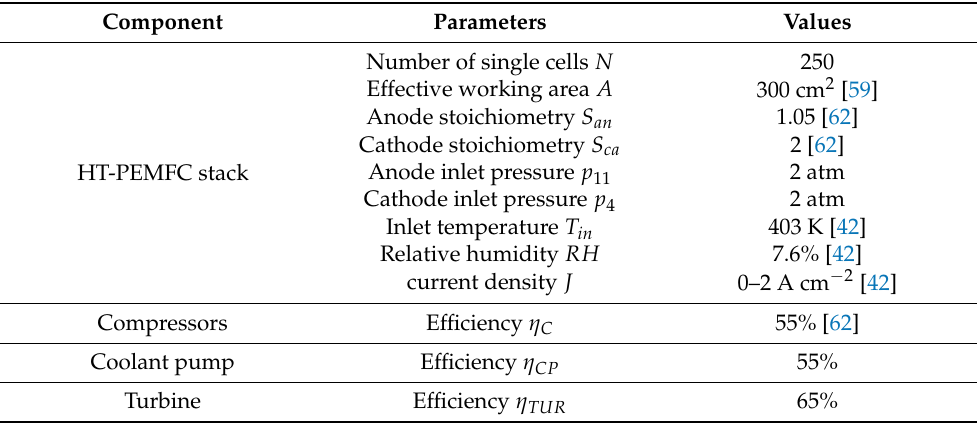
Table 1. Operating and design parameters of a vehicular HT-PEMFC system.